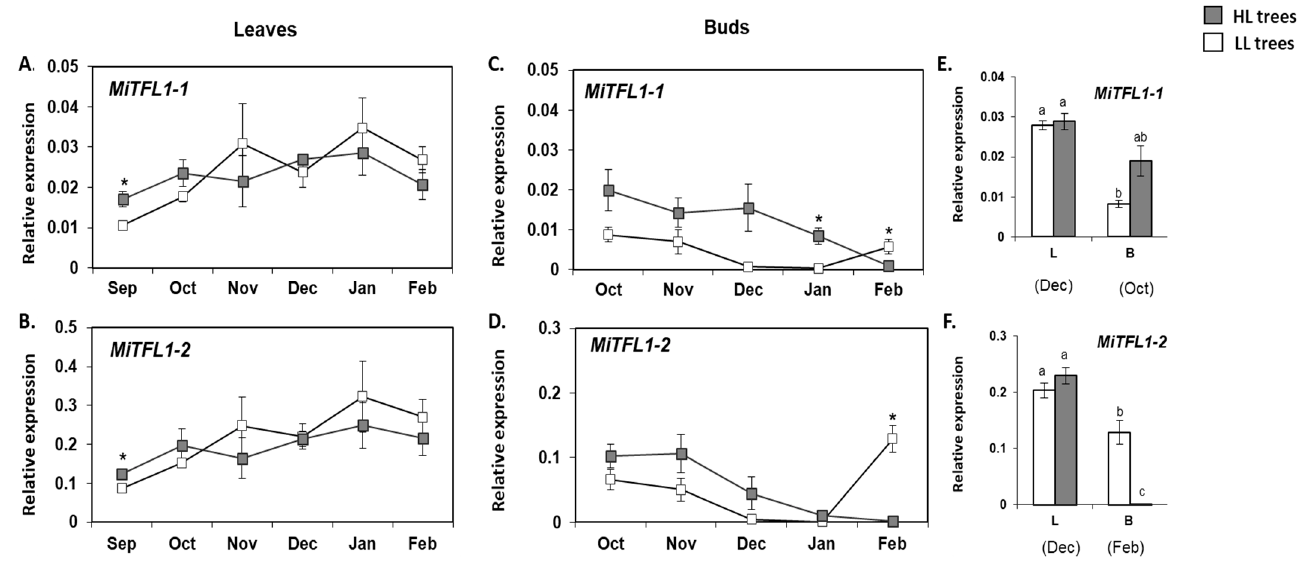
Figure 8. Seasonal expression profiles of MiTFL1-1 and MiTFL1-2 in leaves ( A , B ), and buds ( C , D ), of HL (heavy load), and LL (light load) ‘Shelly’ trees. Tissue sampling was performed using six uniform HL and LL trees that were divided into three pairs of trees at the beginning of May 2017. The collected leaves and terminal buds were dissected and pooled to form three biological replicates (for each tissue and tree status). Data are means±SE of three independent replicates. Asterisks (*) denote a significant difference between the transcript expression in HL and LL tissues at the same time point, using least significant difference (LSD) test, according to pairwise comparison by Student’s t -test, with p ≤ 0.05. Sampling intervals are shown on the X -axis. Comparison of MiTFL1-1 and MiTFl1-2 expression in leaves (L) vs. buds (B), at those time points at which its expression was maximal ( E , F ). Different letters indicate significant differences according to Tukey–Kramer multiple comparison test, with p ≤ 0.05.